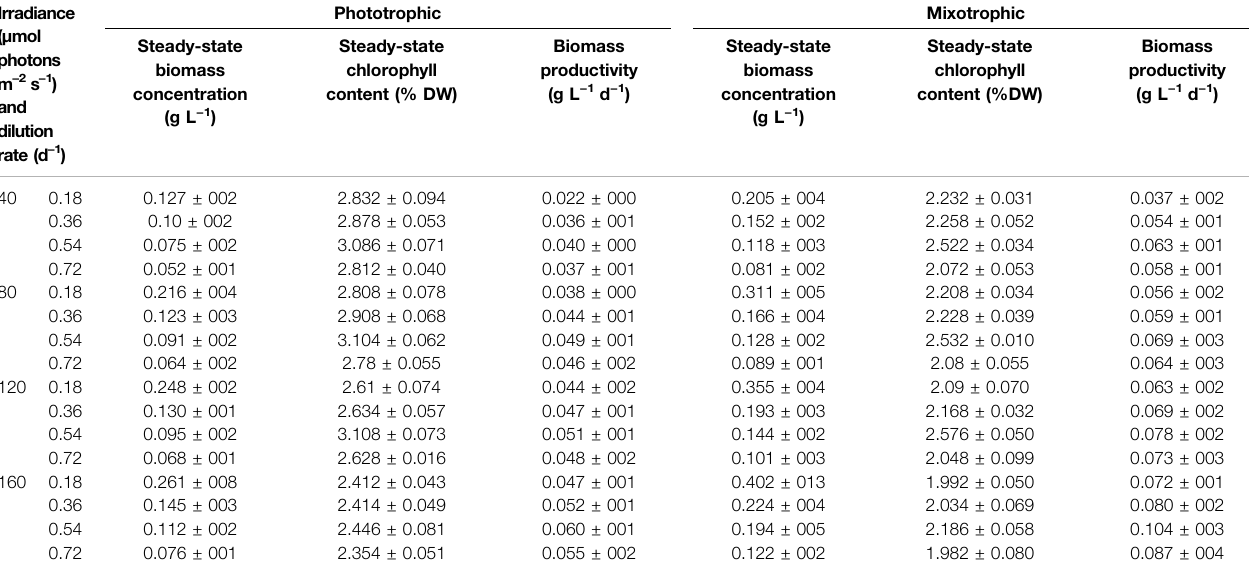
TABLE 1 | Steady-state biomass (DCW), chlorophyll content, and biomass productivity. Irradiance ( μ